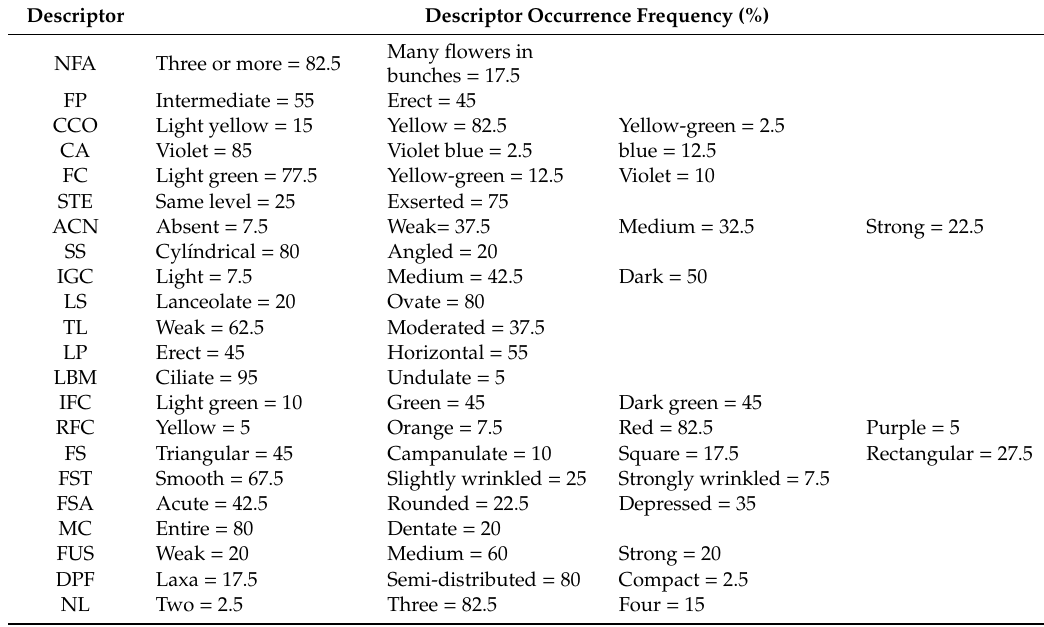
Abbreviations are as in Table